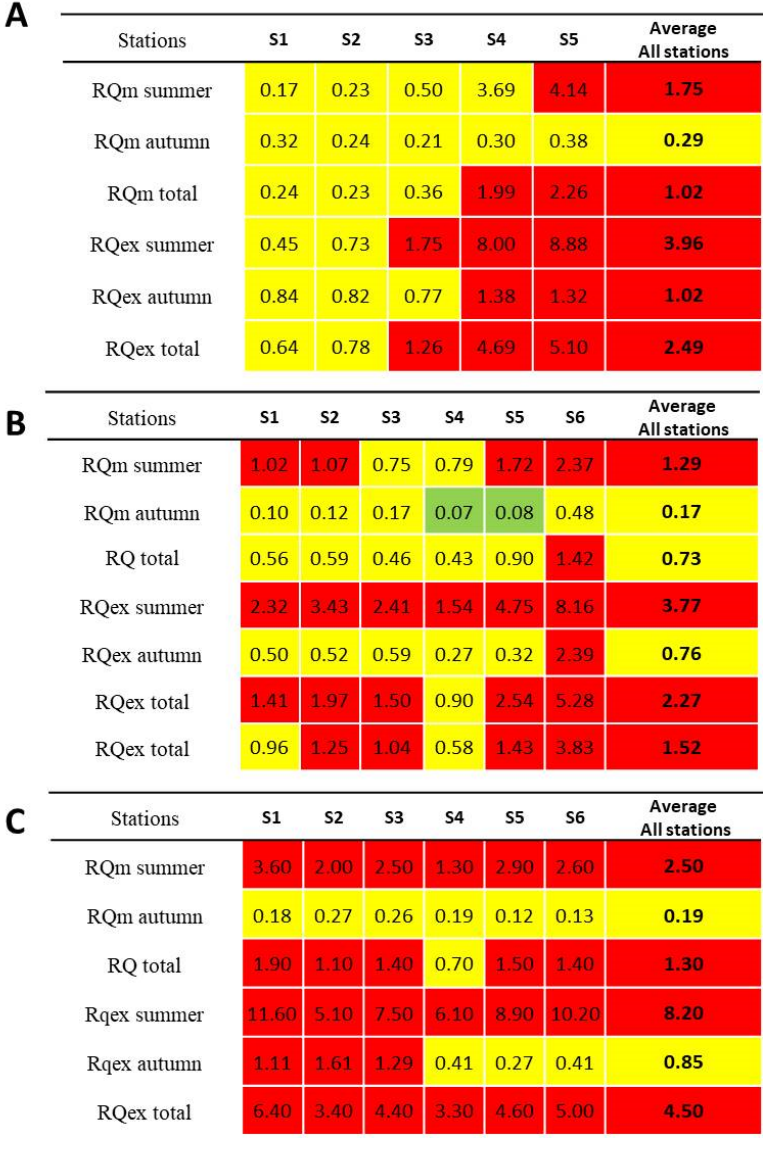
Figure 4. RQm, RQex and RQ total (the mean of the two seasons) of diazinon in the Haraz River ( A ), the Talar River ( B ) and the Babolrood River ( C ). Color indications: red—high risk; yellow—medium risk; green—low risk.